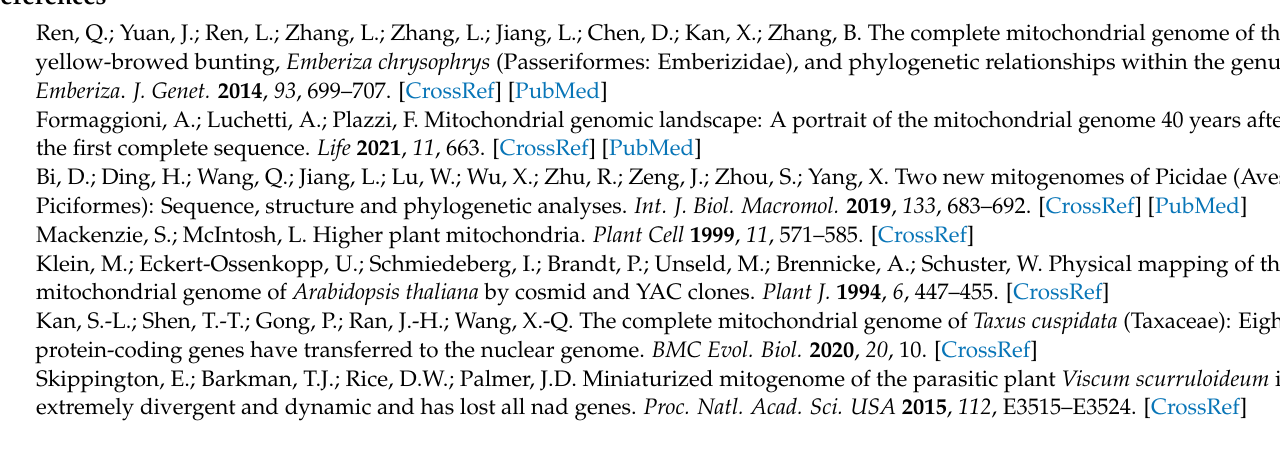
genes; Figure S4: The comparisons of NUMT sequences and their corresponding mitochondrial genes; Figure S5: The homologous nuclear copies of mitochondrial non-core genes that lost in mitogenome of Sedum plumbizincicola ; Figure S6: The predicted secondary structure of 26S mtrRNA of Sedum plumbizincicola ; Table S1: The accession numbers of species selected in the mitophylogenetic analyses; Table S2: Sequencing depths of mitogenome and transferred non-core genes; Table S3: Identified repeats in Sedum plumbizincicola mitogenome; Table S4: The information of RNA editing sites; Table S5: The ENC, GC3s, GC12, and GC3 values of PCGs before and after RNA editing; Table S6: The hit results of flanking regions of ONT reads across the transferred sequence; Table S7: Determination of NUMTs in Sedum plumbizincicola nuclear genome; Table S8: The best Bayesian evolutionary models of each dataset; Data S1: Comparisons of assembly results of two strategies; Data S2: The sequences of master circle and two subgenomic circles; Data S3: The sequences of mitochondrial PCGs be- fore and after RNA editing; Data S4: 5S mtrRNA sequences of 16 investigated species; Data S5: Mitophylogenetic datasets of 34 CDS and 16